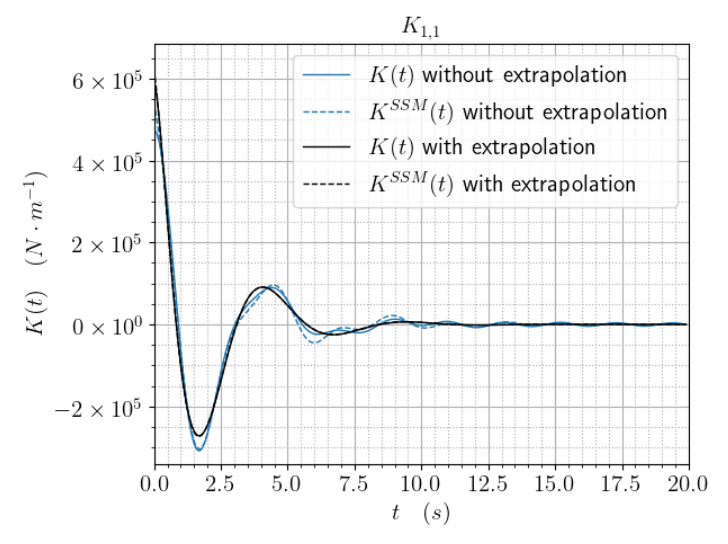
Figure 4. Kernel functions K jk and K SSM